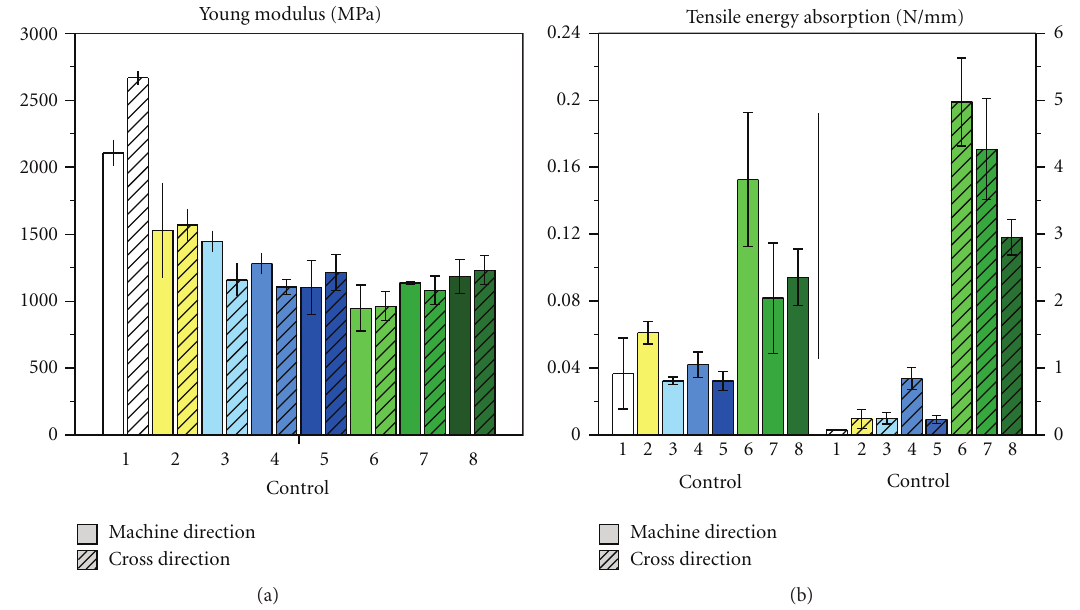
F 5: Young modulus and tensile energy absorption in machine and in cross directions.